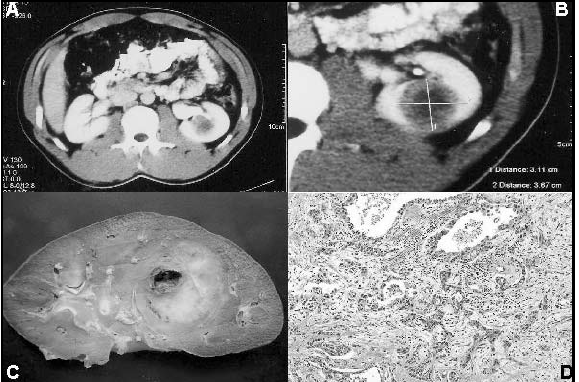
Figura 1 – A e B: tomografia computadorizada mostrando imagens da lesão no rim esquerdo, em cortes transversais; C: macroscopia do rim, em corte sagital, mostrando a lesão na região medular com necrose cística central; D: aspecto microscópico da neoplasia – microcistos, túbulos abortivos em meio a estroma desmoplásico permeado por infiltrado inflamatório mono e polimorfonuclear (HE